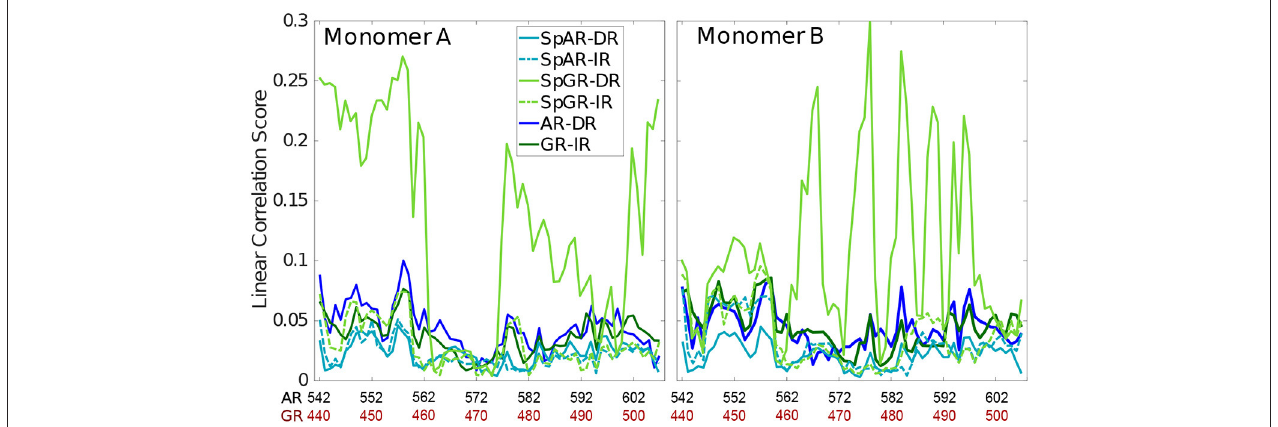
FIGURE 5 | Correlation score per residue, computed for intra-domain correlations with r ki ≥